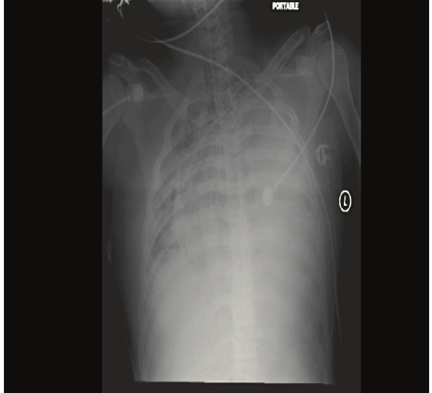
Figure 3: Chest X-ray 5 h after surgery demonstrates complete opacification of the left hemothorax with shift of the mediastinum to the